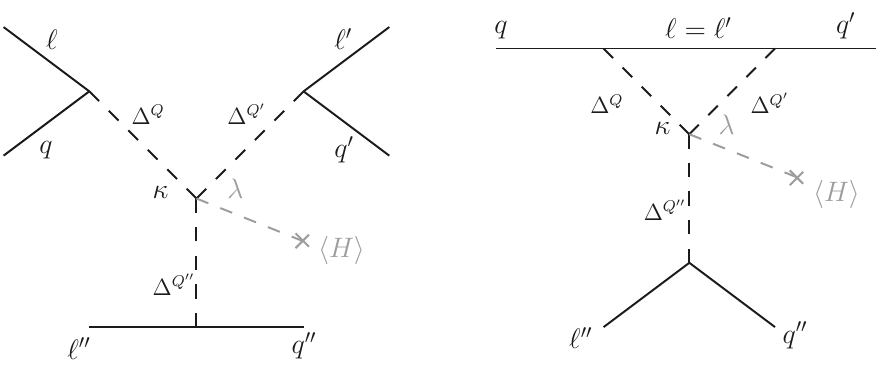
Figure 1 . Two different proton decay topologies generated by the triple-leptoquark interactions. Both can be with or without a Higgs vacuum expectation value leg insertion. q ’s and ‘ ’s denote generic quarks and leptons of the SM while ∆ Q , ∆ Q 0 , and ∆ Q 00 are scalar leptoquark mass eigen- states with electric charges Q , Q 0 , and Q 00 ,